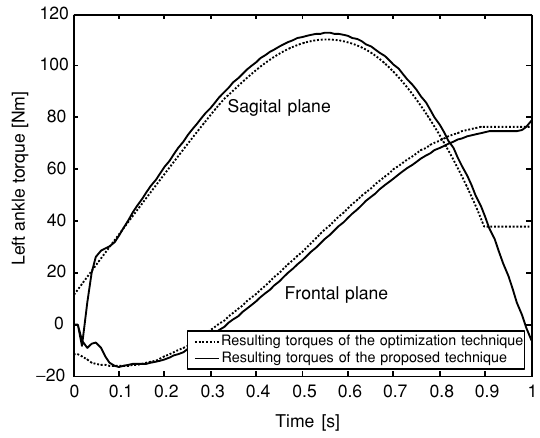
Resulting torques of the optimization technique Resulting torques of the proposed technique 0